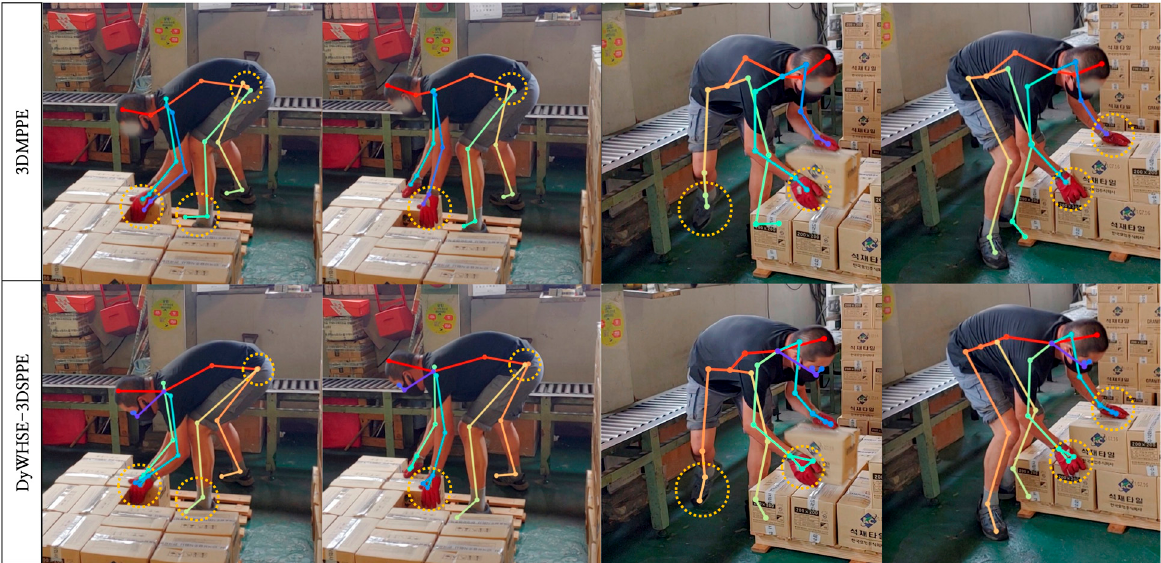
Figure 15. 3DMPPE (MuCo-3DHP, COCO) and DyWHSE-3DSPPE (MuCo-3DHP, COCO) (Dy- WHSE, Human3.6M, MuCo-3DHP, MPII, COCO, and K-pop dance video) pose-estimation results for each model.